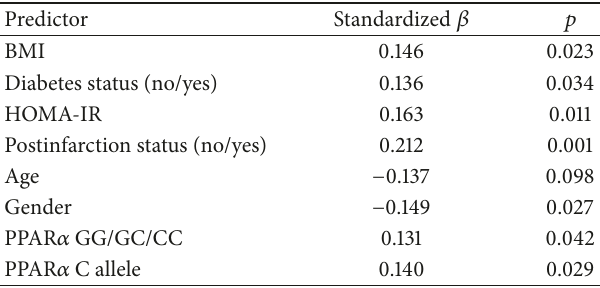
Table 5: Univariate regression analysis between serum fetuin-A concentrations and metabolic parameters (𝑛 = 244) .